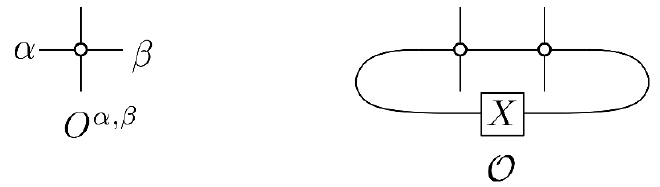
Figure 8 . Alternative parametrization of an MPO O